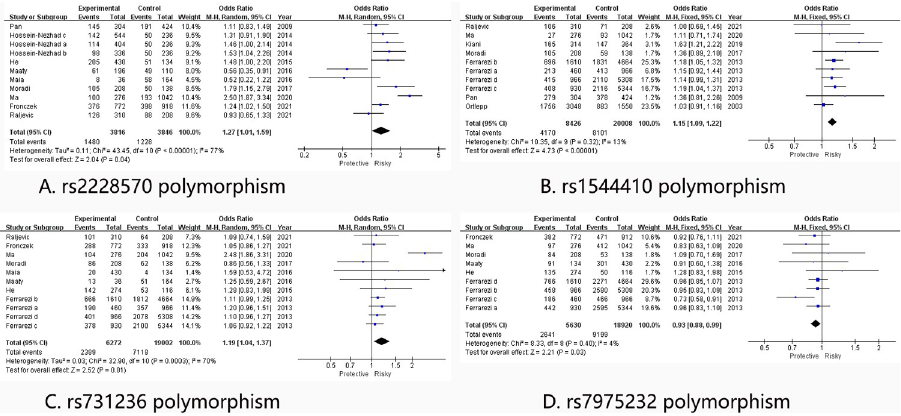
Fig 1. Forest plot of CAD risk associated with the VDR polymorphism. CAD = Coronary artery disease, A: rs2228570 polymorphism; B: rs1544410 polymorphism; C: rs731236 polymorphism; D: rs7975232 polymorphism. VDR = vitamin D receptor, OR = odd ration, CI = confidence